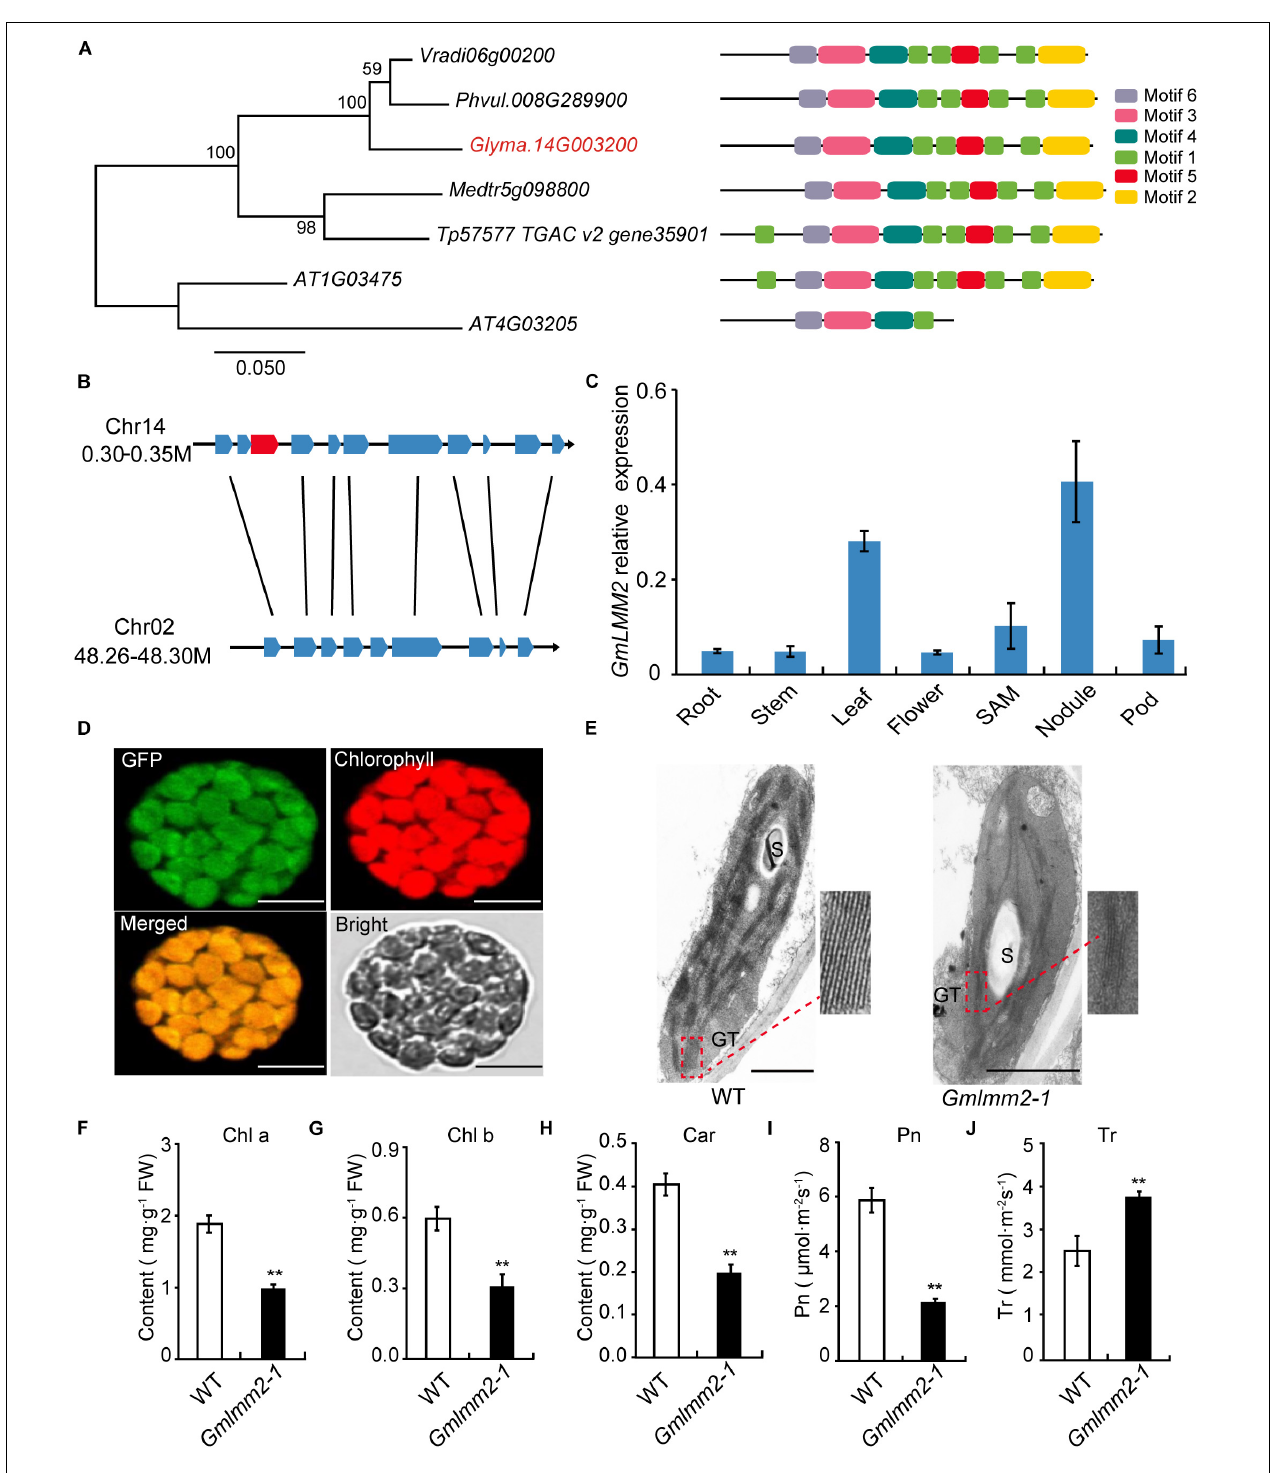
FIGURE 3 | (A) Phylogenetic tree of CPOs/HemF in soybean and other species. Seven CPOs/HemF proteins from six species, including Vigna radiate ( Vradi06g00200 ), Phaseolus vulgaris ( Phvul.008G289900 ), Glycine max ( Glyma.14G003200 ), Medicago truncatula ( Medtr5g098800 ), Trifolium pretense ( Tp57577 TGAC v2 gene35901 ), and Arabidopsis thaliana ( AT1G03475 ; AT4G03205 ). (B) Synteny diagram plot of the genes surrounding the GmLMM2 gene. (C) Expression pattern of GmLMM2 in different tissues of “Williams 82” (WT). (D) GmLMM2 localized to the chloroplasts. GFP, GFP signal of GmLMM2; Chlorophyll, chlorophyll auto fluorescence; Merged, merged image of GFP and chlorophyll. Scale bars = 10 µ m. (E) Chloroplast structure of “Williams 82” (WT) and the Gmlmm2-1 mutant. S, starch granule; GT, granal thylakoid. Scale bars = 1 µ m. (F–J) Pigment contents and photosynthesis parameters of “Williams 82” and the Gmlmm2-1 mutant. (F) Chl a, chlorophyll a; (G) Chl b, chlorophyll b; (H) Car, carotenoid; (I) Pn, photosynthetic rate; (J) Tr, transpiration rate. Asterisks indications are same as Figure 1 .